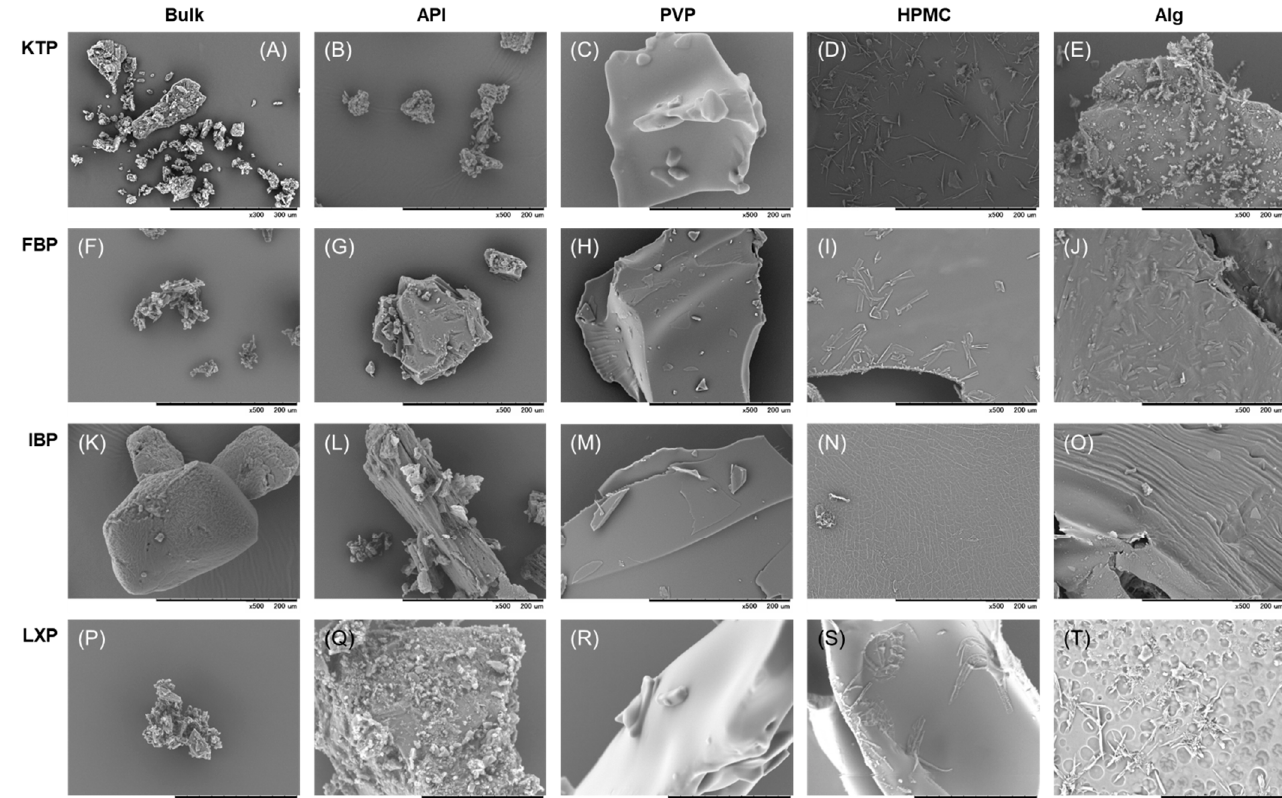
Figure 4. SEM images of API bulk and film formulations for ( A – E ) KTP, ( F – J ) FBP, ( K – O ) IBP, and ( P – T ) LXP. Images are shown for ( A , F , K , P ) API bulk, ( B , G , L , Q ) control solid formulation